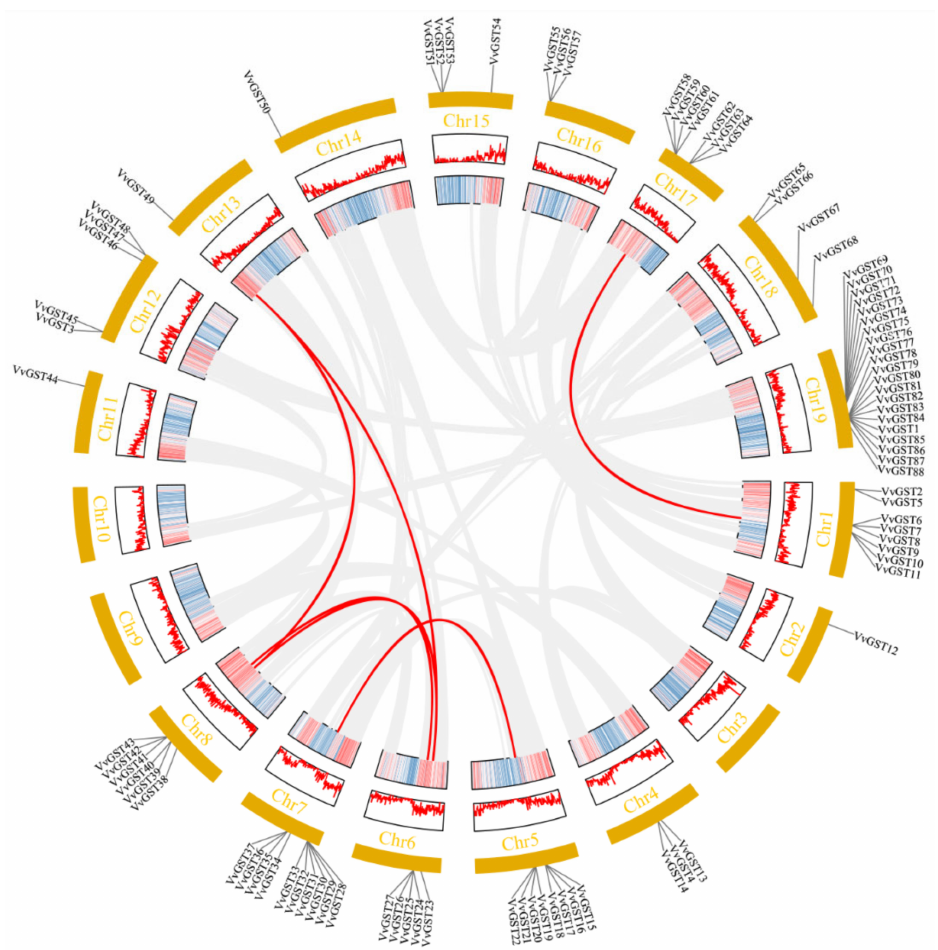
Figure 3. The collinearity analysis of the GST gene family in grape. The GST genes were mapped onto different chromosomes. The red lines indicate segmental duplicated gene pairs of grape GST genes, while the gray lines delineate synteny blocks in the grape